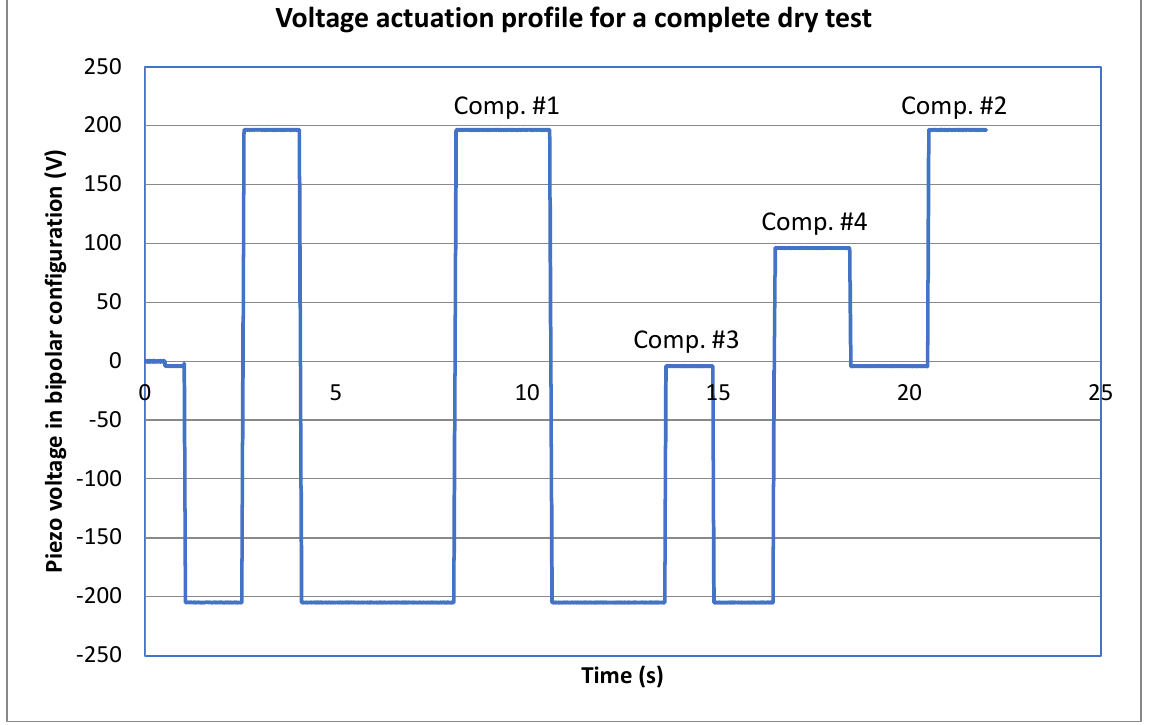
Figure 12. Piezo voltage in bipolar configuration during an extended dry test sequence. A full PUSH (and PULL) corresponds to an applied voltage of +200 V (and − 200 V). From t = 0 s to t = 10 s, the sequence is equivalent to the dry test sequence shown in Figure 9.